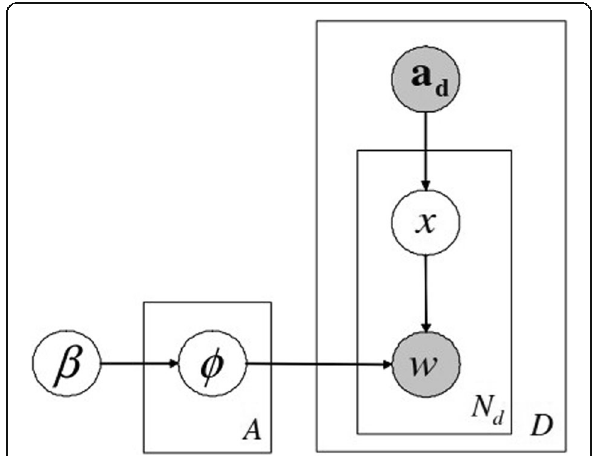
Fig. 1 Author model (Rosen-Zvi et al.,